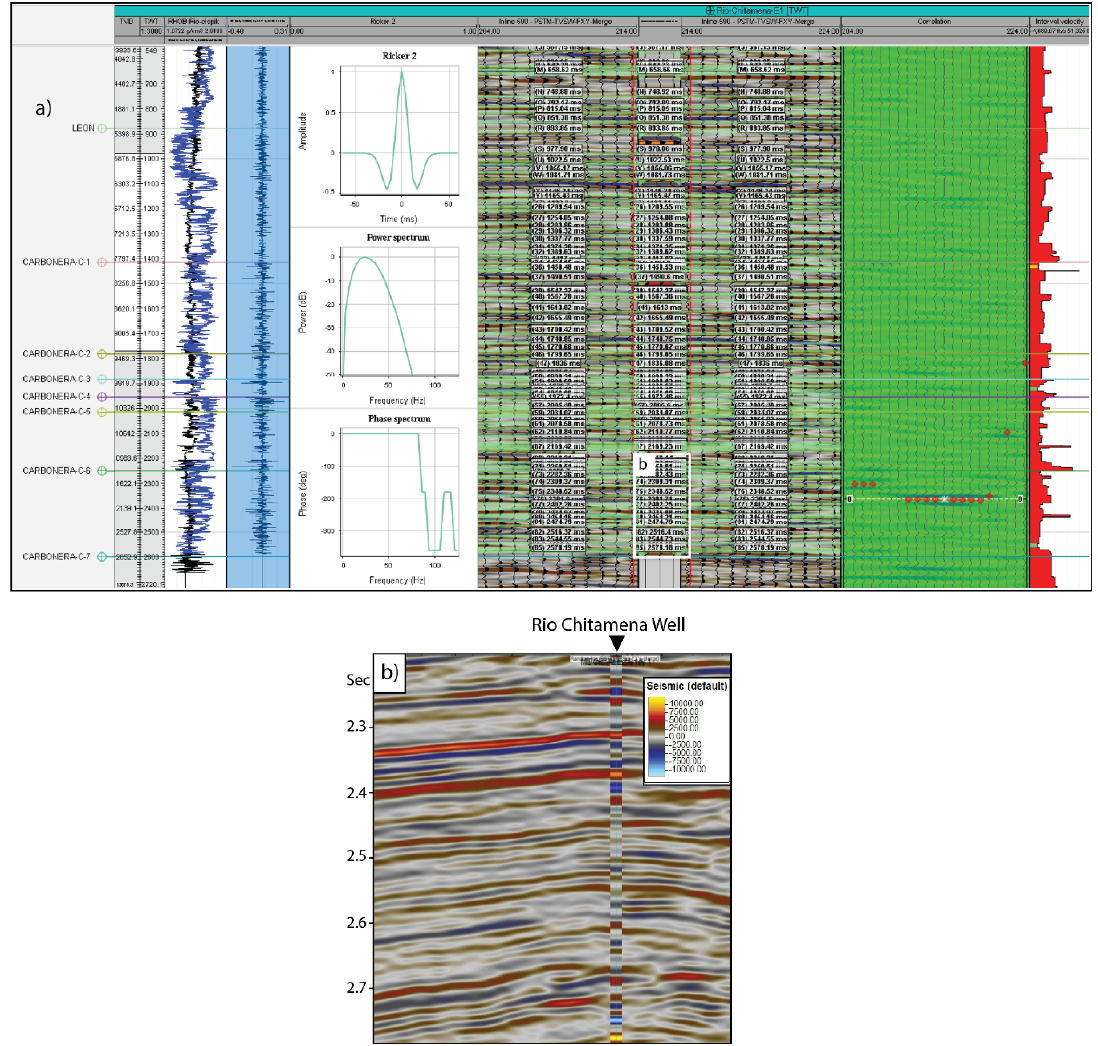
Figure 4. ( a ) Synthetic seismogram with sonic and density logs. ( b ) Synthetic seismogram for the Rio Chitamena well displayed on a seismic section.